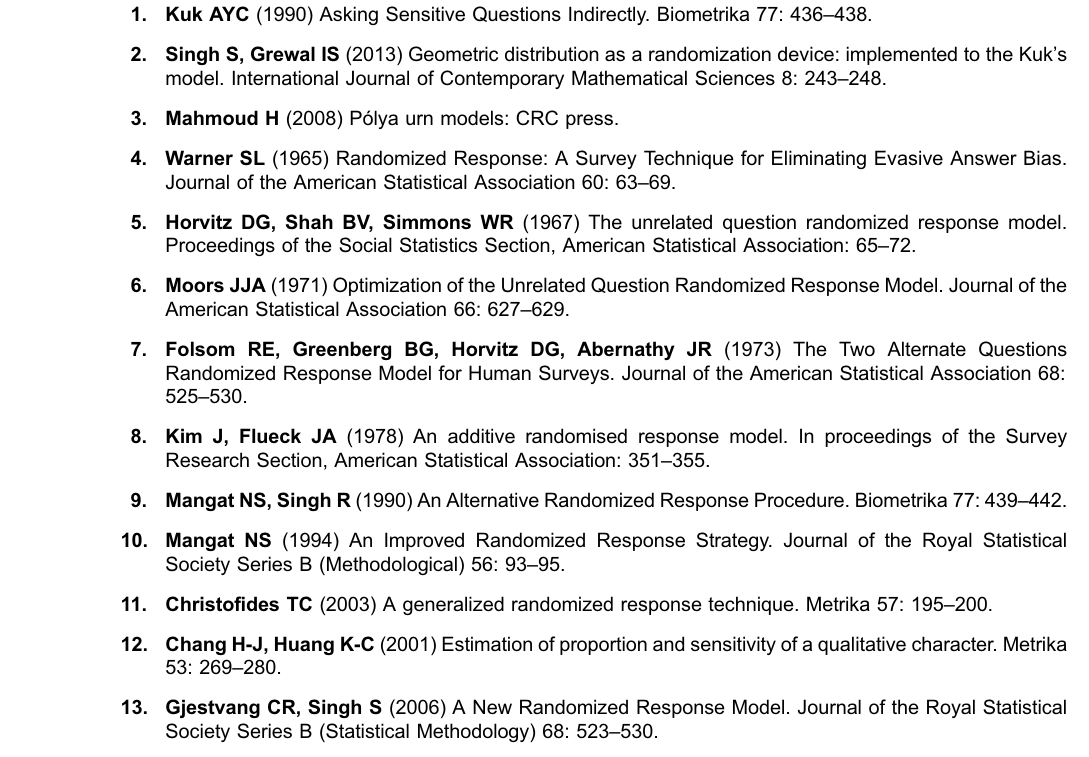
S9 Table. Relative efficiency of ^ p S10 Table. Relative efficiency of ^ p S11 Table. Data obtained through proposed RRT 1 using n ~ 1000 , b a 1 S12 Table. Data obtained through [1] RRT using h S13 Table. Data obtained through [2] RRT using h (cid:2)